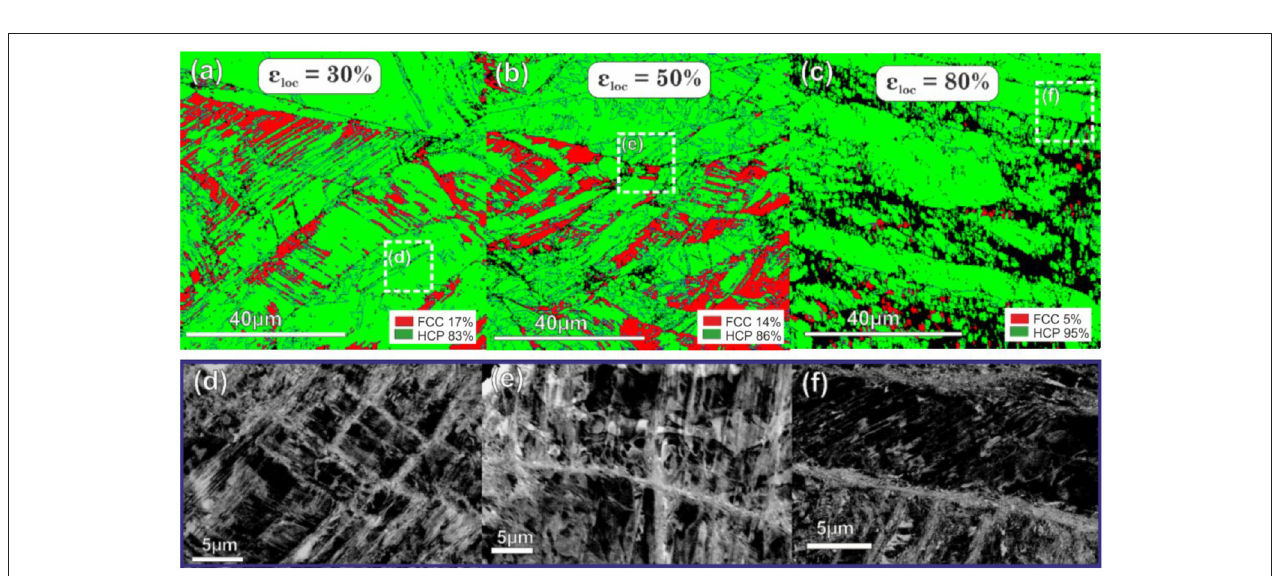
FIGURE 9 | EBSD phase maps (a–c) and ECC images (d–f) showing the microstructures in the coarse-grained DP-HEA sample with an average grain size of ∼ 38 µ m and a starting HCP phase fraction of ∼ 72% at varying local strain ( ε loc ) levels (30, 50, and 80%) after tensile testing at a constant strain rate of 5 × 10 − 3 s − 1 .